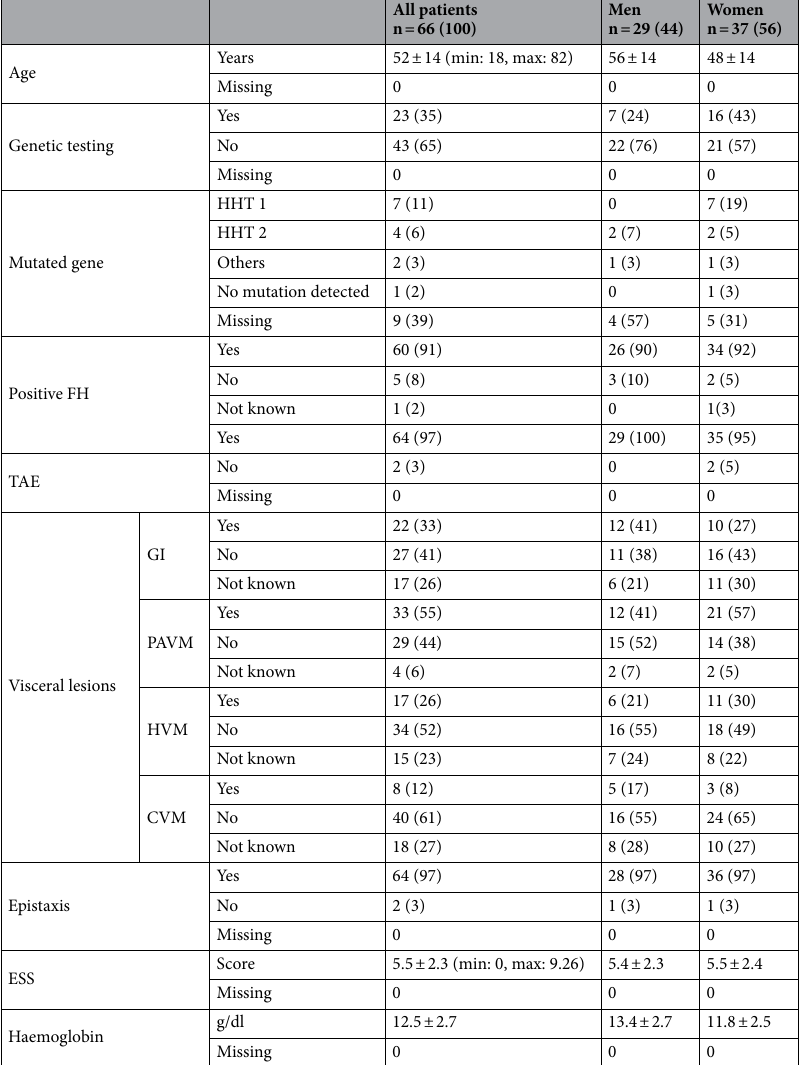
Table 1. Clinical characteristics of 66 patients with hereditary haemorrhagic telangiectasia. TAE teleangiectasia, FH family history, GI gastrointestinal bleedings, PAVM pulmonary arteriovenous malformations, HVM hepatic vascular malformations, CVM cerebral vascular malformations, ESS Epistaxis Severity Score with a scale from 1 = mild epistaxis to 10 = severe epistaxis. Data is shown in number of patients [(n) and (percentage)] or mean ±